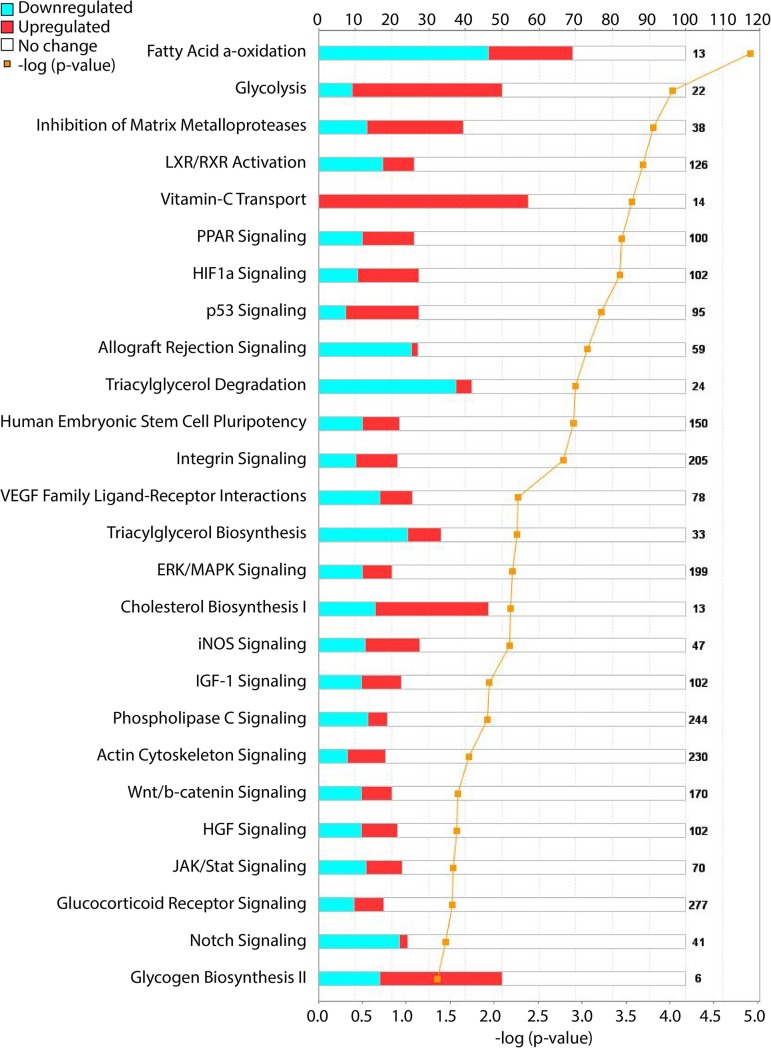
Selections of canonical pathways enriched for DEGs associated with adipocyte’s functionality.Significantly up- or downregulated genes (p<0.05 and 2-fold change) in engineered compared to native adipose tissues were analysed with IPA. Bars represent the percentage of genes significantly altered in the pathway. The numbers of genes included in the pathway are indicated at the right. Negative log of the p-values are represented by the yellow line. Downregulated and upregulated genes in each pathway are represented in blue and red, respectively.